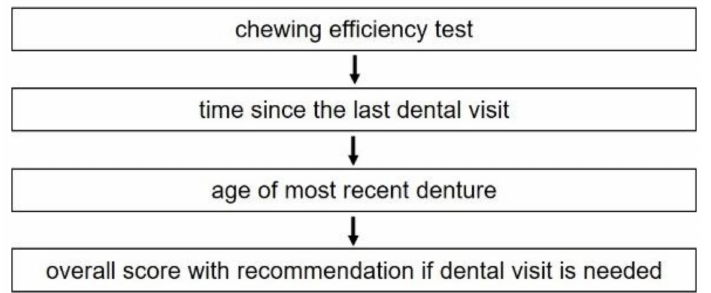
Figure 1. Flow scheme of the different steps of the MDA to acquire an overall score for recommenda- tion if a dental visit is